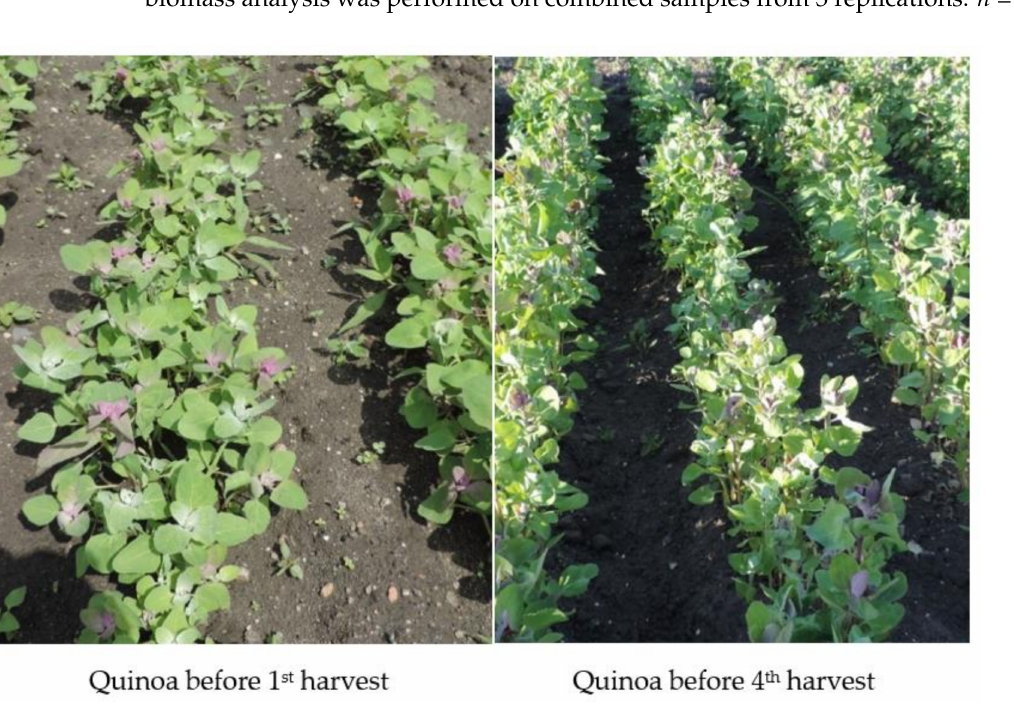
Figure 1. Quinoa experiment on medium